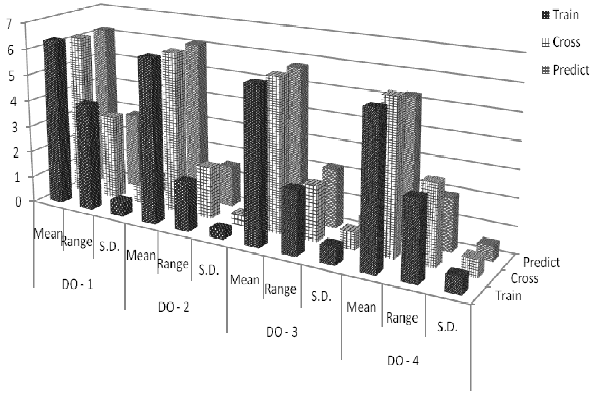
Fig. 5. Statistical properties (i.e. mean, standard deviation, range) for training, validation and testing data sets.